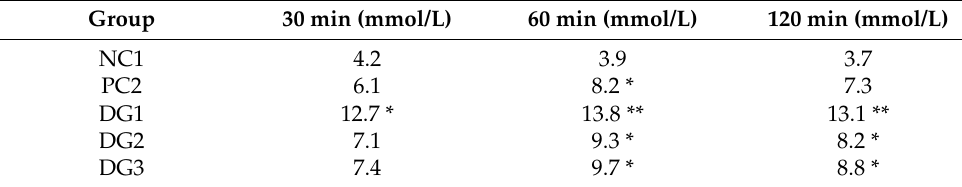
Table 6. Glucose tolerance effect in glucose-induced hyperglycemia.